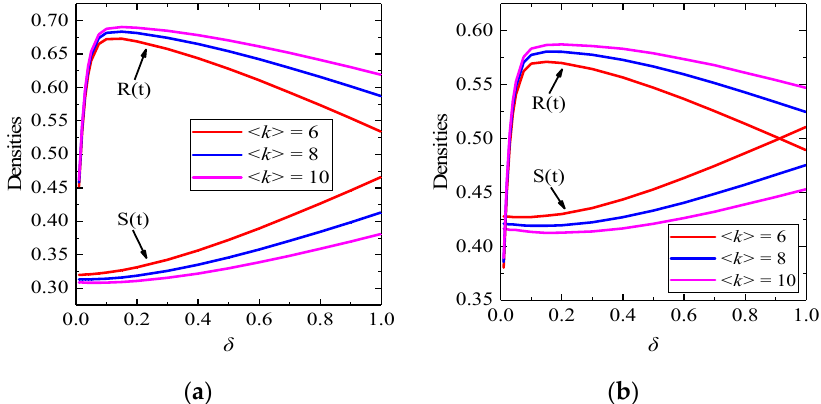
Figure 9. Variation of the density of ignorant people and immunizers when they reach the steady state with the forgetting rate δ in ( a ) WS network and ( b ) BA network.